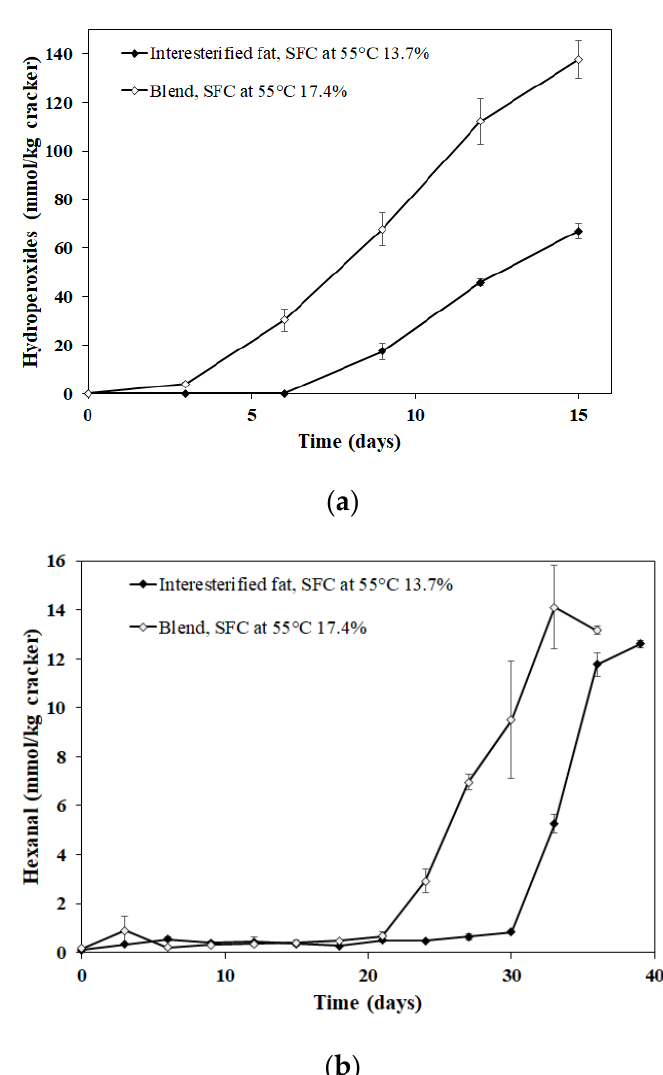
Figure 4. Formation of ( a ) lipid hydroperoxides and ( b ) headspace hexanal in crackers made from fat blend (17.4% solid fat content) and interesterified fat (13.7% solid fat content), which had similar fatty acid profile and tocopherol profile at 55 °C. Data points represent means ( n = 3) ± standard deviations. Some standard deviations lie within the data points.